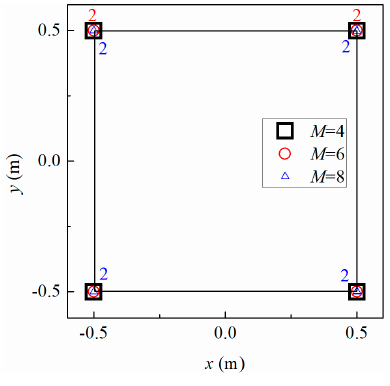
Figure 11. Optimized array deployments for direction-of-arrival (DOA) estimation in square constraint area.